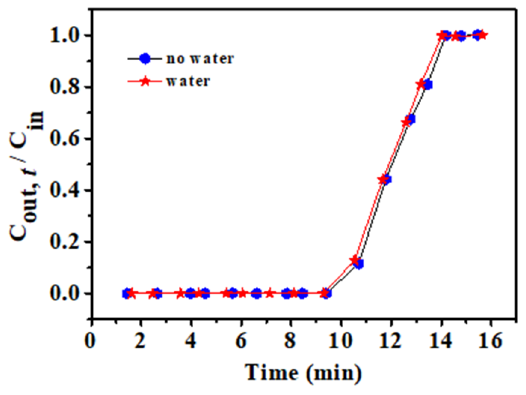
Figure 10. Influence of the presence of water on the adsorption of L2.